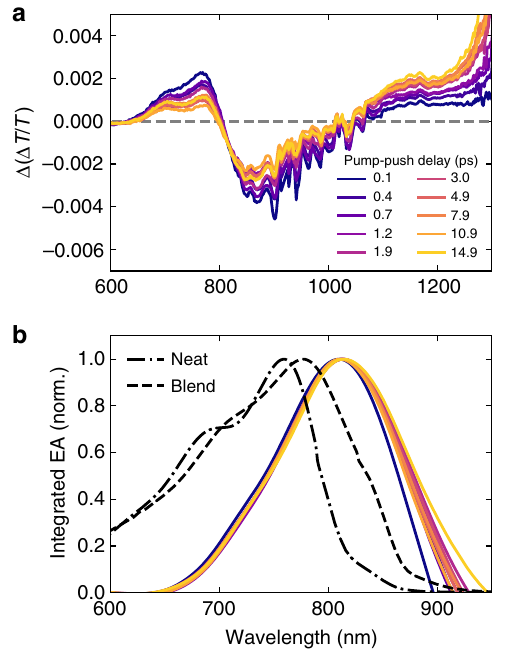
Fig. 4 Evolution of push-induced electroabsorption reveals ordered interface. a Push-induced, differential TA spectra averaged between 0.25 and 0.50 ps push-probe delay at various pump-push delays at a pump fl uence of 50 μ J cm − 2 and push fl uence of 90 μ J cm − 2 . b Integrated push- induced, differential TA spectra from a as compared to the neat and blend steady-state absorption for